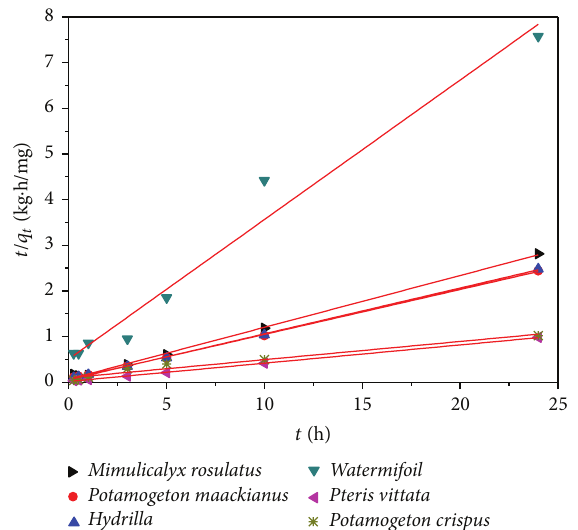
Figure 5: The linearized pseudo-second-order kinetics model for the removal of As (III) ( 𝑇 = 13 ∘ C, initial As (III) concentration = 1.000 mg/L).